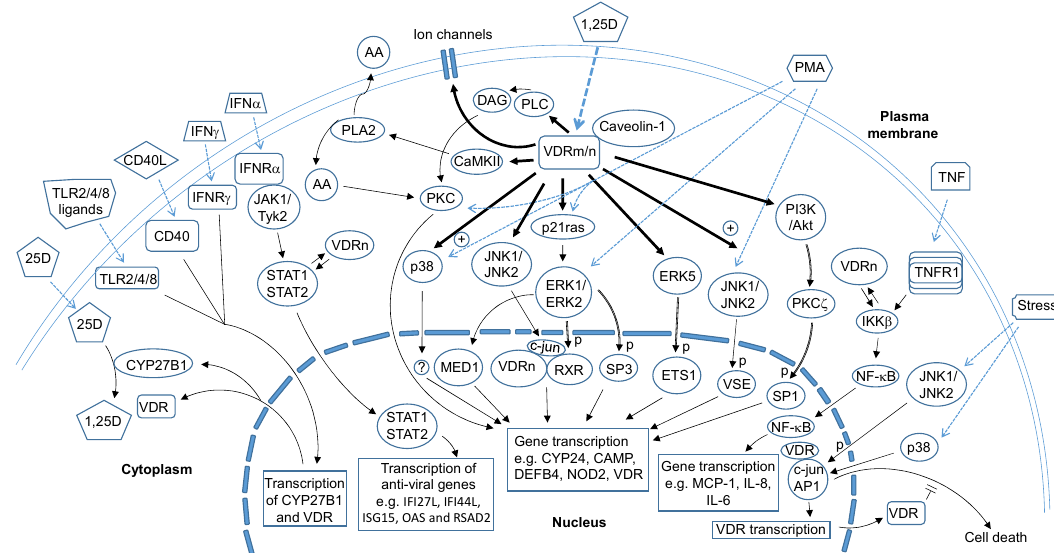
Figure 1. The non-genomic actions of 1,25D. 1,25D acts via both genomic and non-genomic actions to regulate the expression of vitamin D responsive genes such as CY24 and those that promote anti-microbial defence. The non-genomic mechanisms, downstream of VDRn and/or VRDm complexed to caveolin1, include the activation of intracellular signalling molecules, such as PKC, PI3K, MAP kinases, CaMKII and PLA 2 . The range of signalling molecules being activated is related to the cell-type and status of cell maturation. Targets of these kinases include transcription factors, e.g., SP1, SP3 and RXR that bind to response elements on the promoters of vitamin D-responsive genes. Another non-genomic action of 1,25D involves the regulation of VDR binding to target proteins such as STAT1 and IKK β that enables the cross modulation by 1,25D of gene expression mediated by non-vitamin D ligands, including IFN- α and TNF- α . This mechanism provides an avenue for 1,25D to directly regulate immune responses and anti-viral actions of immune and non-immune cells. Ligation of CD40, IFN- γ receptor and TLR2/4/8 causes an upregulation of VDR and CYP27B1 expression and this facilitates an autocrine mechanism that enables the increased availability of 1,25D and VDR to cooperate with these immune receptors for various responses, including anti-microbial activity while modulating the expression of cytokines, chemokines and type 1 interferons. The VDR, independently of 1,25D, can also exhibits a non-classical action that involves its interaction with proteins such as transcription factors or kinases to modulate cellular responses, including immune/antiviral response and stress-induced cell death. Bold arrows denote direct actions of 1,25D. Dotted arrows denote ligand binding to their receptors. Reversible arrows indicate protein-protein interaction. Arrows with double lines indicate kinase-substrate relationship. Abbreviations: 25D: 25-hydroxyvitamin D; 1,25D: 1,25 dihydroxyvitamin D; VDRm/n: membrane or nuclear vitamin D receptor; CYP27B1 and CYP24: cytochromes P450C1 α and P450C24; PLA2: phospholipase A2; CaMKII: Calcium/calmodulin protein kinase II; AA: arachidonic acid; DAG: diacylglycerol; PLC: phospholipase C; IFN: interferon; TLR: Toll-like receptor; PMA: phorbol 12-myristate 13-acetate; PKC: protein kinase C; PI3K: phosphatidylinositol 3-kinase; Akt: protein kinase B; IKK: I- κ B kinase; MED1; Mediator Complex Subunit 1; RXR: retinoic acid X receptor; Specificity Protein; ETS 1: Avian Erythroblastosis Virus E26 Oncogene Homolog-1; VSE: Vitamin D stimulatory element; STAT: Signal Transducer and Activator of Transcription; JAK: Janus kinase; Tyk: Tyrosine kinase; ERK: Extracellular signal Regulated protein Kinase; JNK: c-Jun N-terminal Kinase; MCP-1: Monocyte chemoattractant protein 1; CAMP: Cathelicidin Antimicrobial Peptide; IFI27L: Interferon, Alpha-Inducible Protein 27 like; IFI44L: Interferon-Induced Protein 44-Like; ISG15: Interferon-Stimulated Protein, 15 KDa; OAS: 2 1 -5 1 -Oligoadenylate Synthetase; RSAD2: Radical S-Adenosyl Methionine Domain Containing 2; “p” denotes phosphorylation; “+” denotes